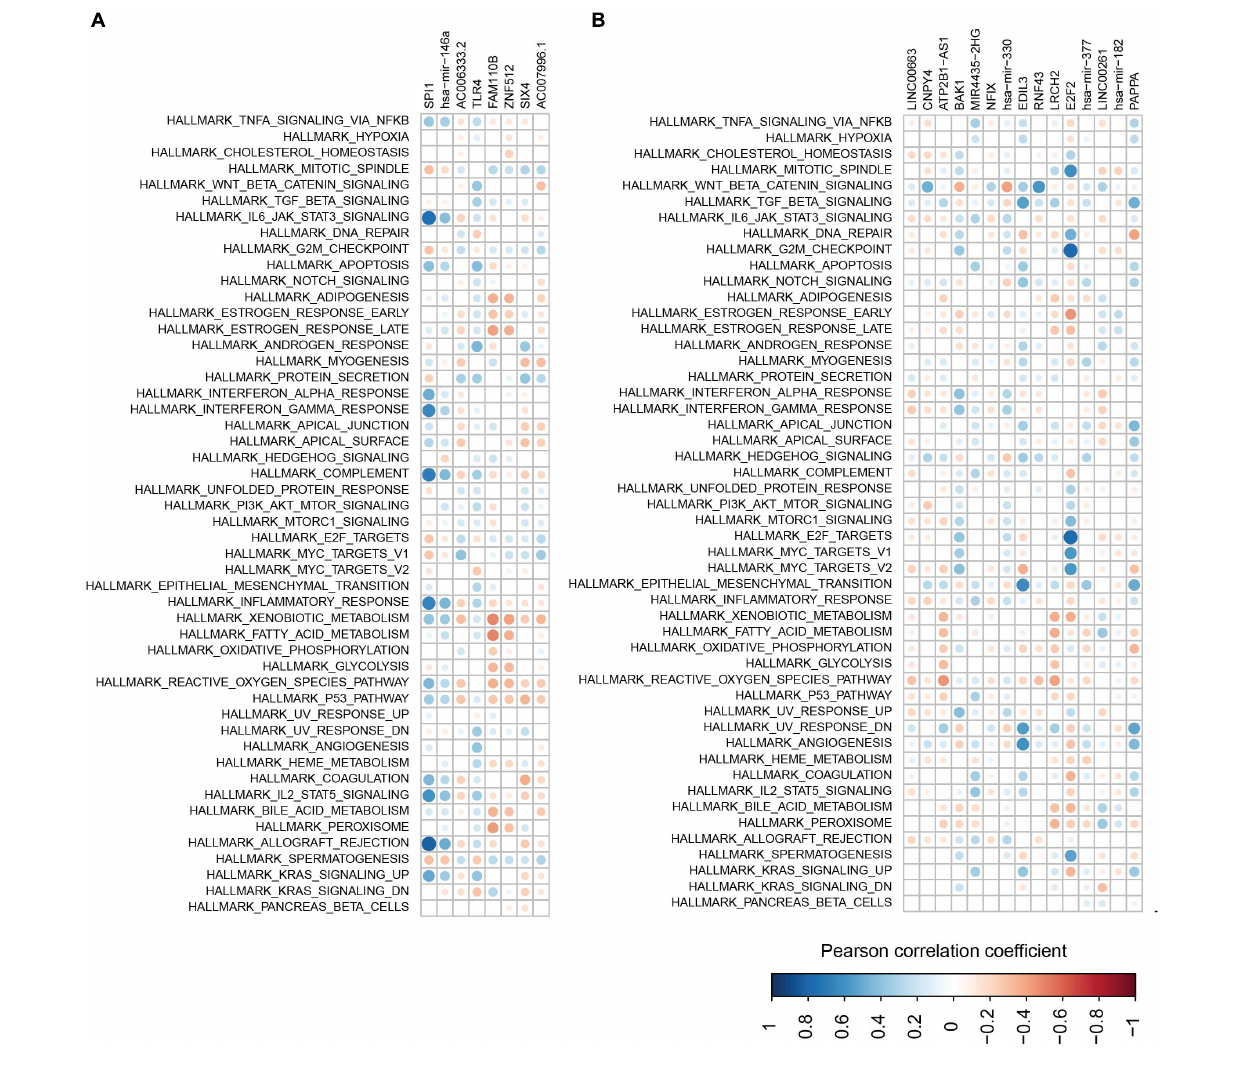
FIGURE 9 | The correlations between RNAs and pathways. (A,B) Correlations between pathway and RNAs from the first module (A) and the second module (B)